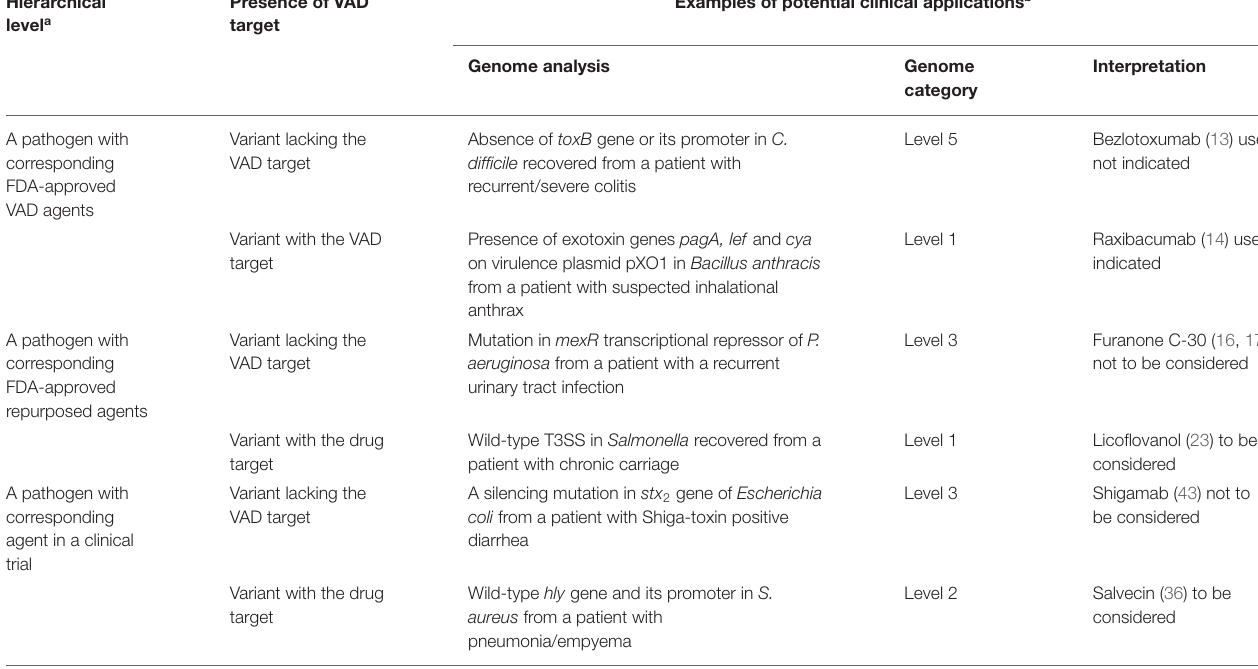
TABLE 2 | Example of an actionable hierarchy for identified genomic